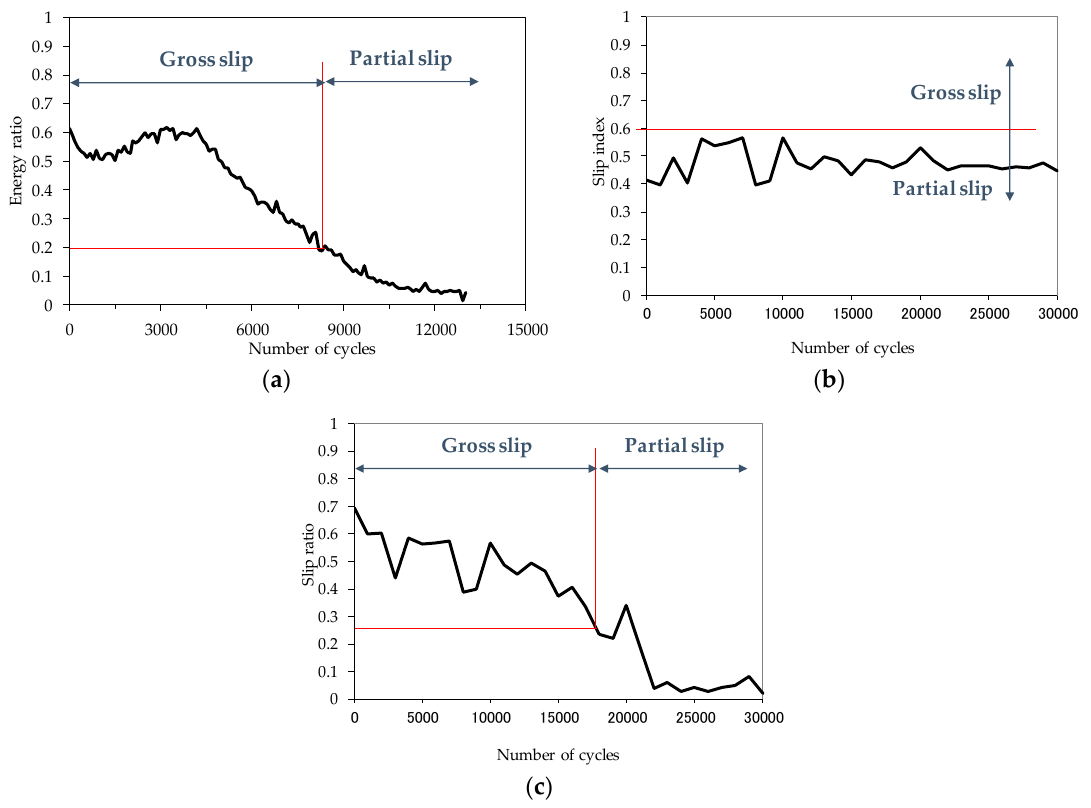
Figure 7. Changes of parameters of dry film lubricants during a fretting test [24,25]: ( a ) Energy ratio;